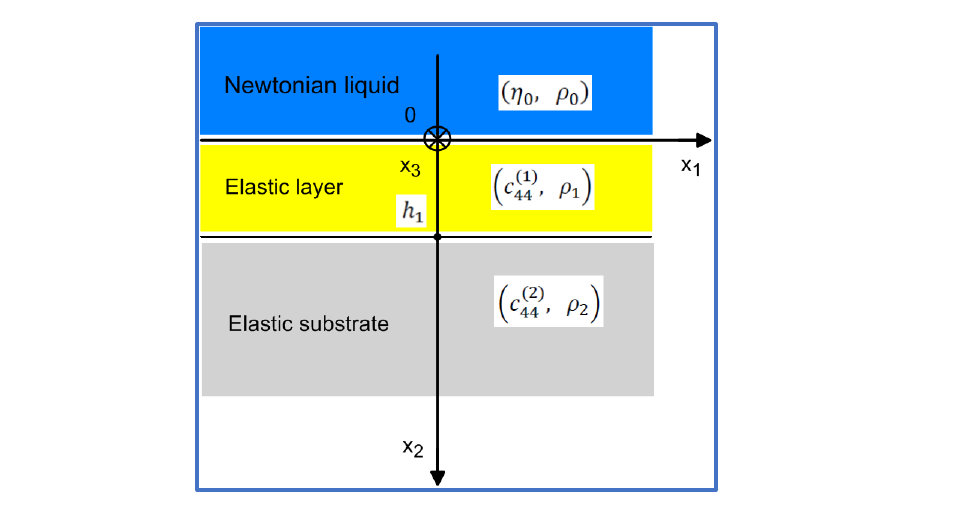
Figure 1. Cross-section of the waveguide employed in Love wave sensors. Elastic surface layer (PMMA) of thickness h 1 is bonded rigidly to the elastic substrate (ST-cut-Quartz). Top surface of the waveguide is in contact with a semi-infinite Newtonian liquid.